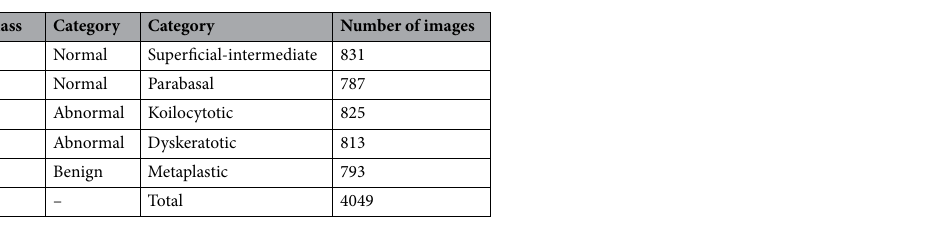
Table 3. Distribution of images in the SIPaKMeD pap smear